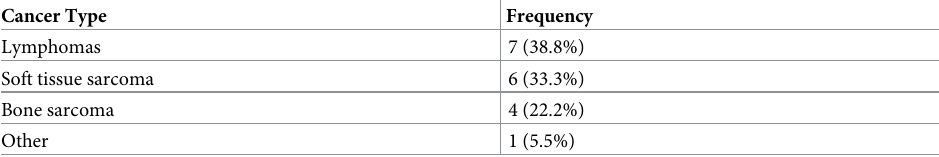
Table 3. Pediatric common cancer